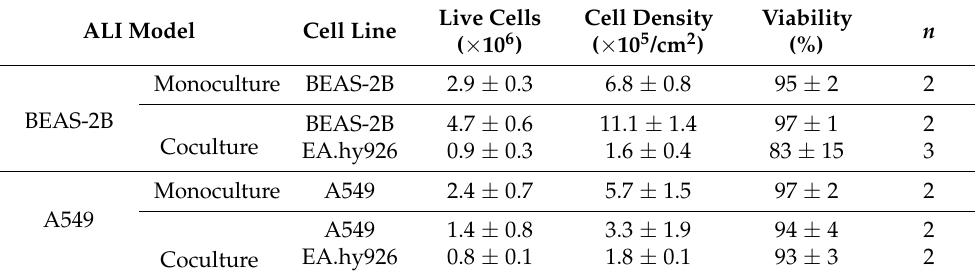
Table 3. Comparison of the barrier integrity of mono- and cocultures of BEAS-2B/EA.hy926 and A549/EA.hy926 cells, by measurement of fluorescein sodium salt and Ag permeation. Results are presented as mean permeation with SD of n = 2–3 independent experiments with single or duplicate inserts. Permeation is presented as the basolateral concentration (µM) and as the basolateral con- centration relative to the deposited apical concentration (%). Results for A549/EA.hy926 cultures are based on our previous publication [39]. NC: negative control. PBS: phosphate-buffered saline, NM- 300K DIS: dispersant control, NM-300K low: nominal 1 µg/cm 2 , NM-300K high: nominal 10 µg/cm 2 .